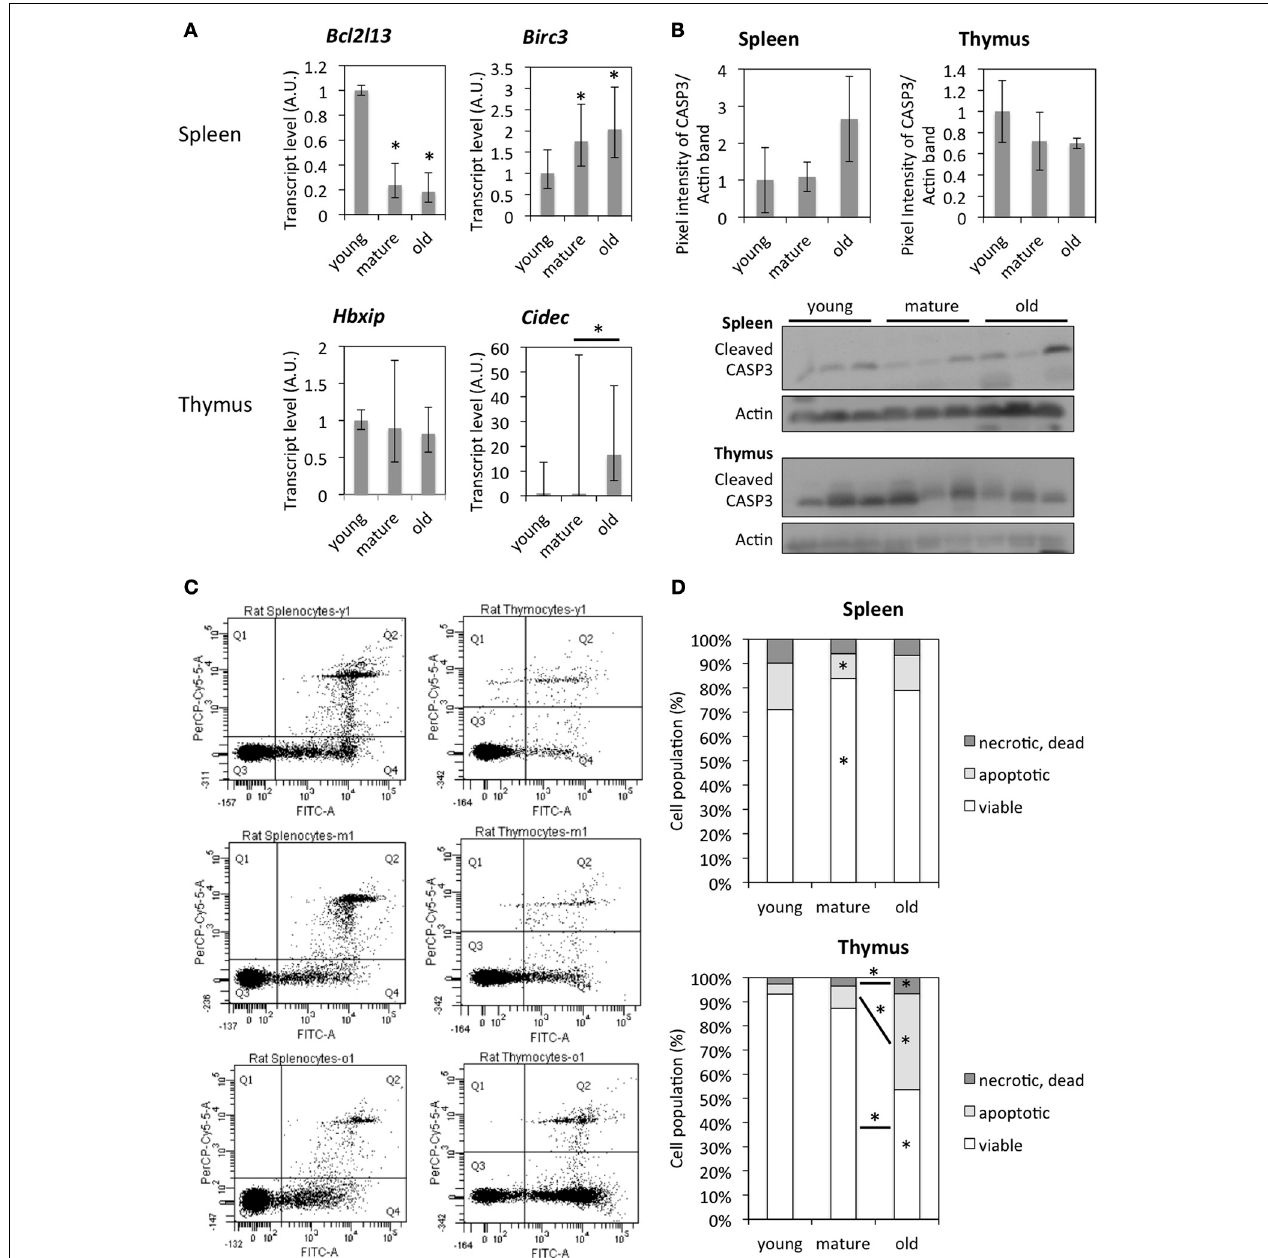
FIGURE 7 | Age-dependent changes in the activity of the apoptotic pathway. (A) mRNA expression levels of genes involved in the apoptotic pathway by qRT-PCR. The data points represent means normalized to the expression in young animals ± 95% confidence intervals. (B) Western blot images and quantification of cleaved CASP3 band intensity normalized to Actin levels and protein levels detected in tissues from young animals. Each data point represents mean ± standard deviation. (C) Plots of cell populations were measured by flow cytometry,